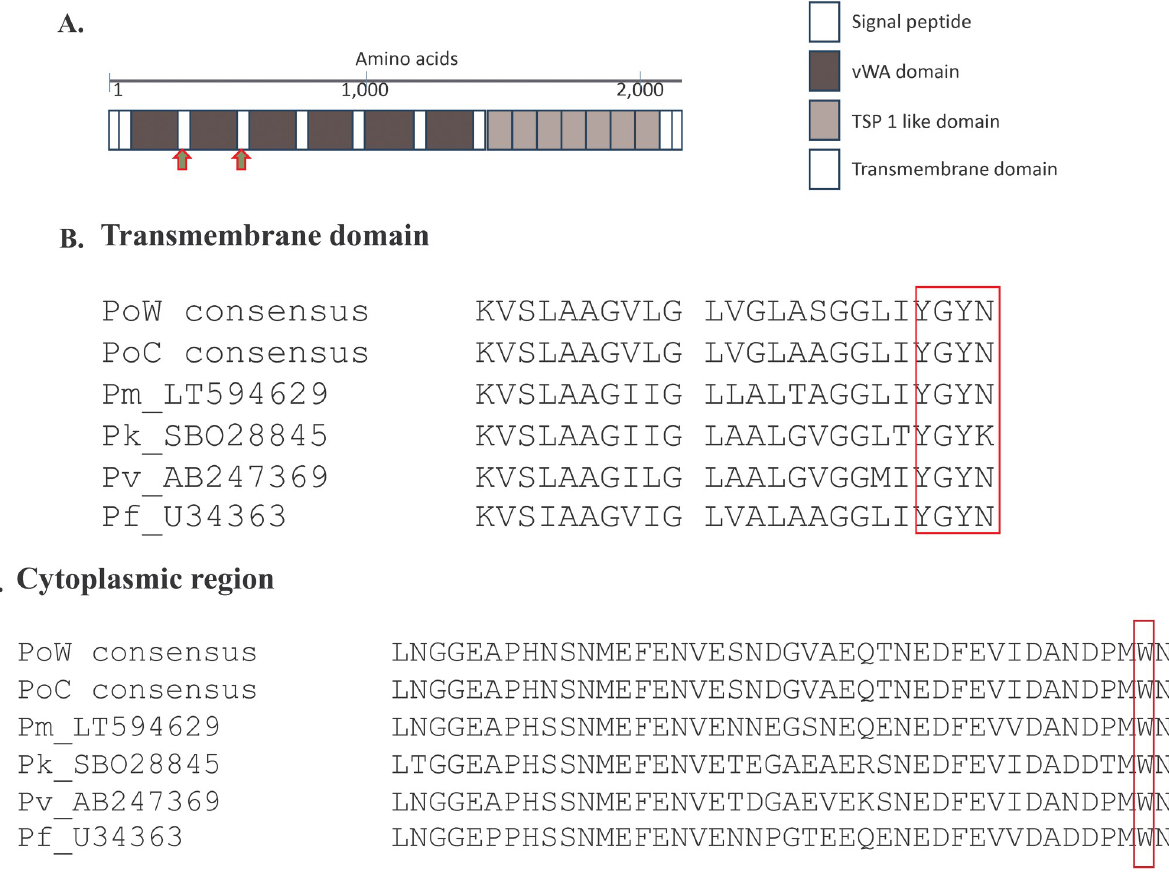
Fig 1. The Plasmodium ctrp gene. (A) Schematic representation of the domain structure of Plasmodium ctrp gene. The Plasmodium CTRP composes of N-terminal signal peptide, six vWA domain, seven tandemly arrayed TSP 1- like domains, and the C-terminal transmembrane domain. Based on P . falciparum CTRP domain structure analysis, the PoCTRP domains could be drawn from multiple sequence alignment. Amino acid sequence signature for each Plasmodium species were observed between vWA 1–2 domains and between vWA 2–3 domains as indicated by red arrows. (B) Amino acid alignment of the transmembrane (TM) domain with the box representing the conserved tyrosine-based motif involved in cellular trafficking. (C) Amino acid alignment of the cytoplasmic region. The conserved tryptophan residue that interacts with motility actomyosin machinery was marked with the